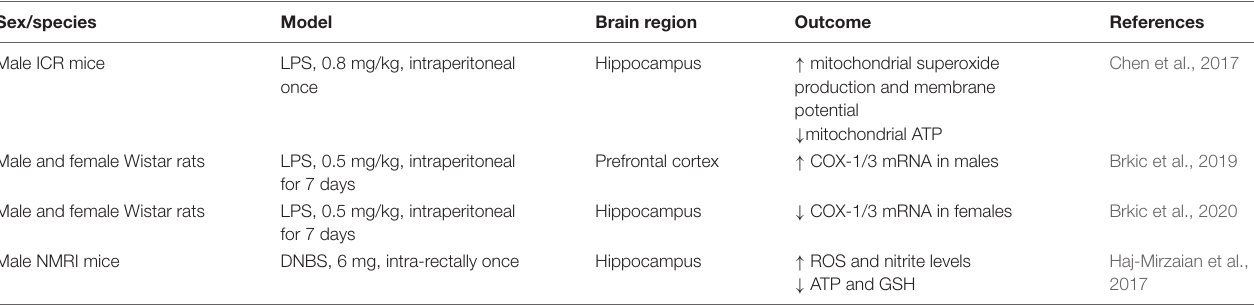
TABLE 1 | Summary of some of the studies showing mitochondrial dysfunction in mouse models of peripheral inflammation-induced depression-like behavior.